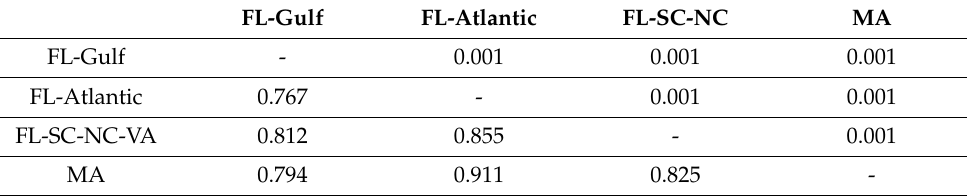
Table 5. Pairwise PhiST (below diagonal) and p -values (above diagonal) among